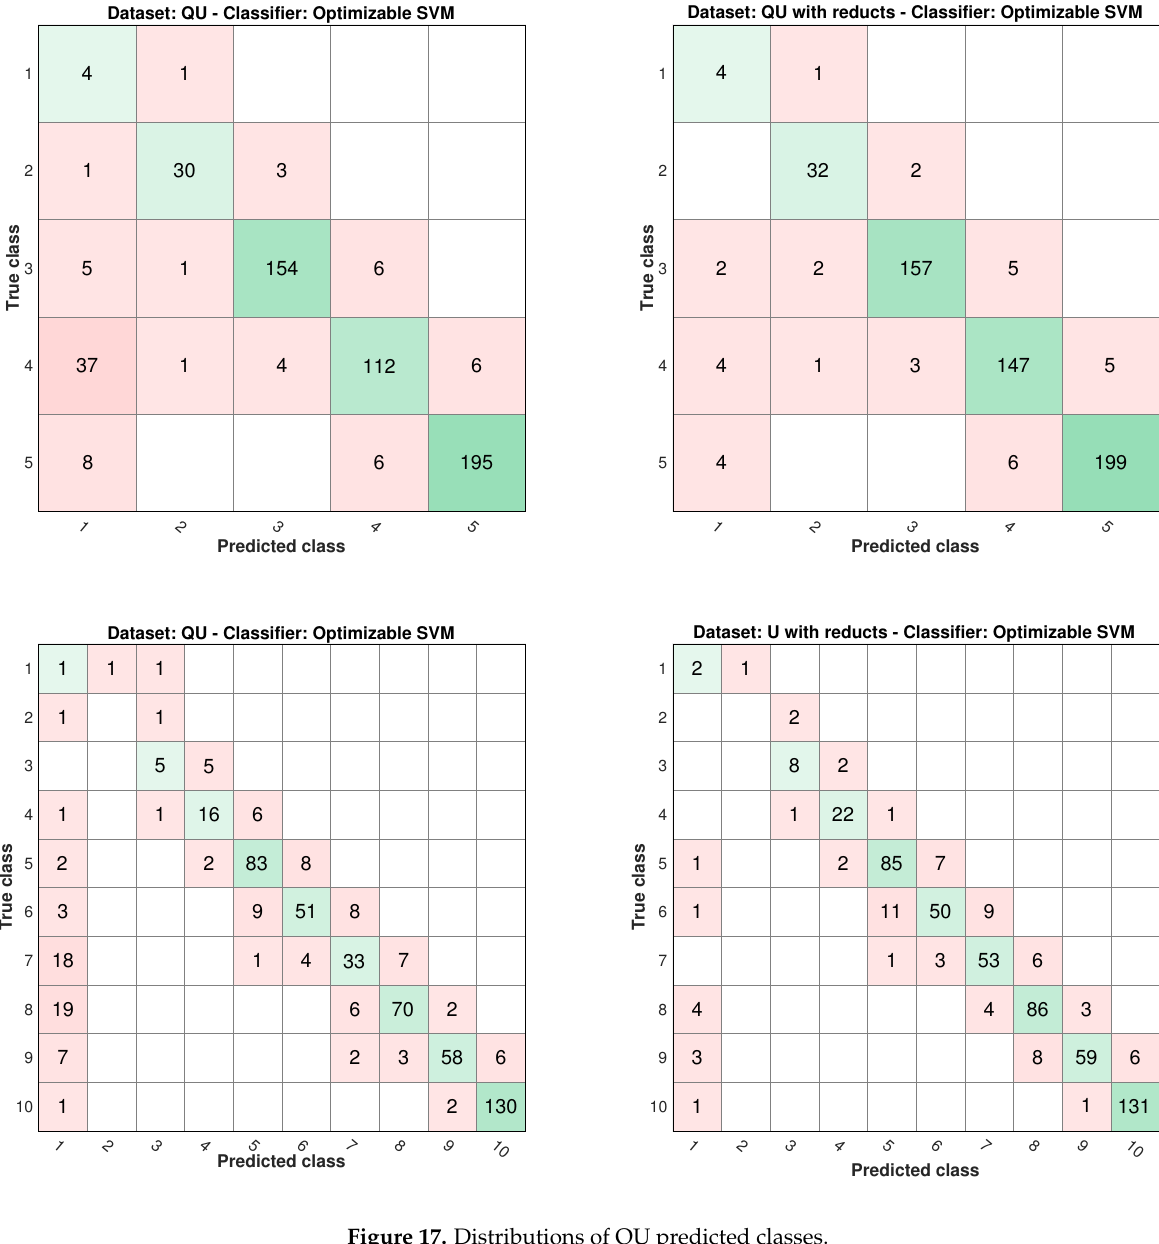
Figure 17. Distributions of QU predicted